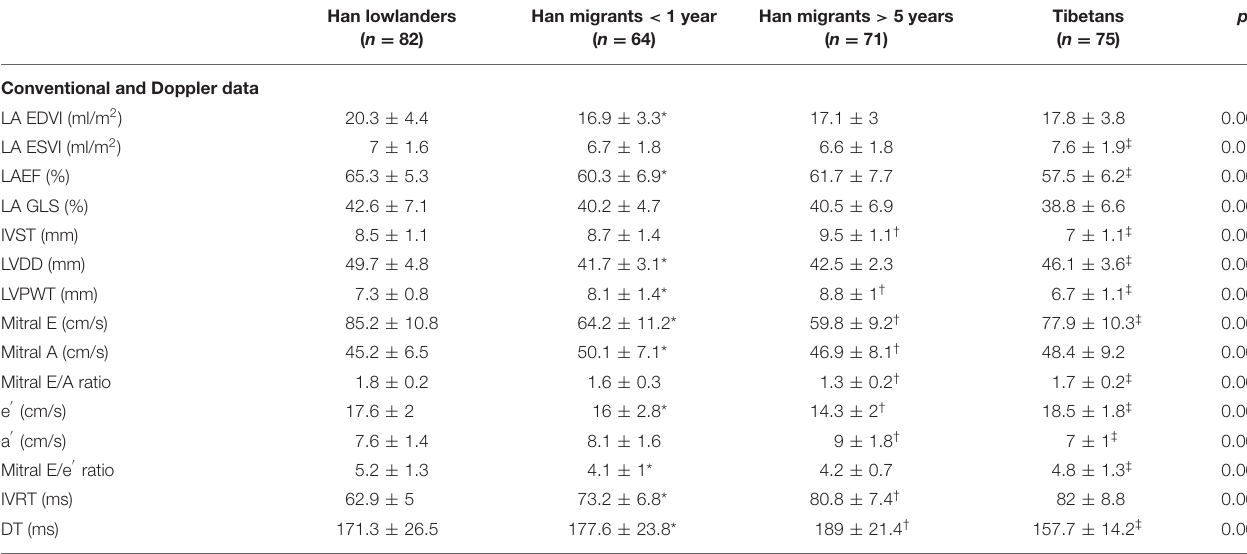
TABLE 3 | Echocardiographic parameters of left heart in Han lowlanders, Han migrants and native Tibetans.